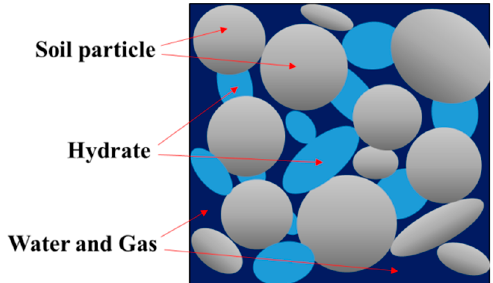
Figure 1. Diagram of the structure of hydrate-bearing sediments.